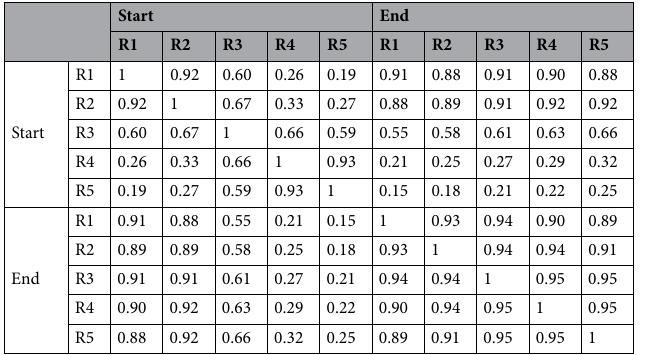
Table 4. Bray–Curtis Similarity index of R1 to R5 at Stage A and Stage B. R = 0.452, p = 0.0083. Consortia with algae/sludge 10:1, 5:1, 1:1, 1:5 and 1:10 (donated as R1 to R5). Start (the operation start-up, the 0 h) and End (the operation end, the 48th